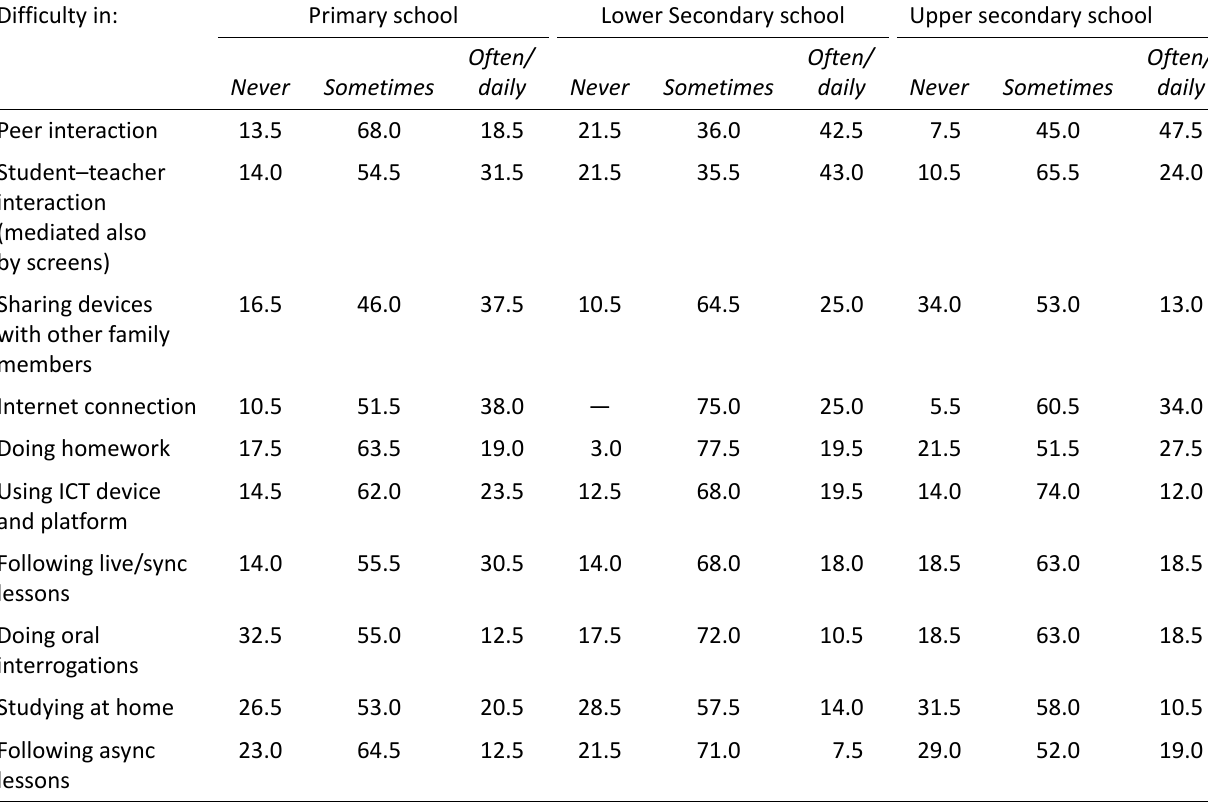
Table 1. Main difficulties mentioned by students during school closures.